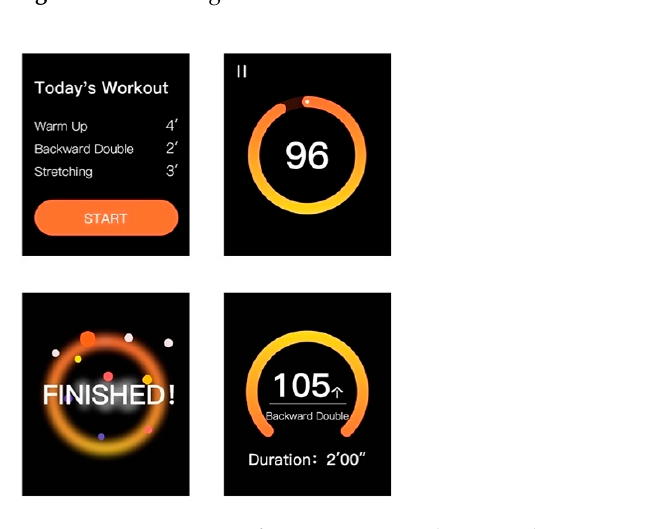
Figure 10. Exercise guidance.